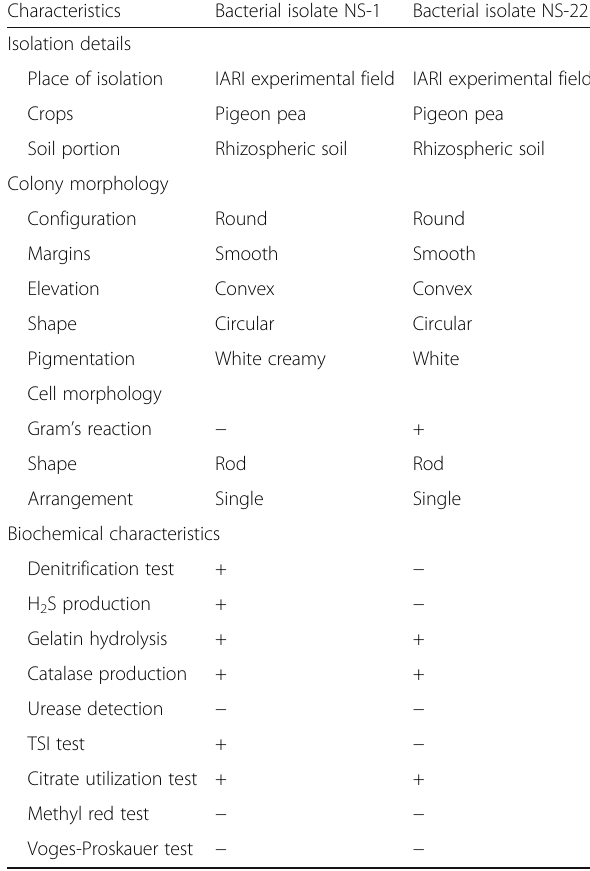
Table 5 Phenotypic, morphological and biochemical characteristics of the selected chitinolytic and potent antifungal bacterial isolates